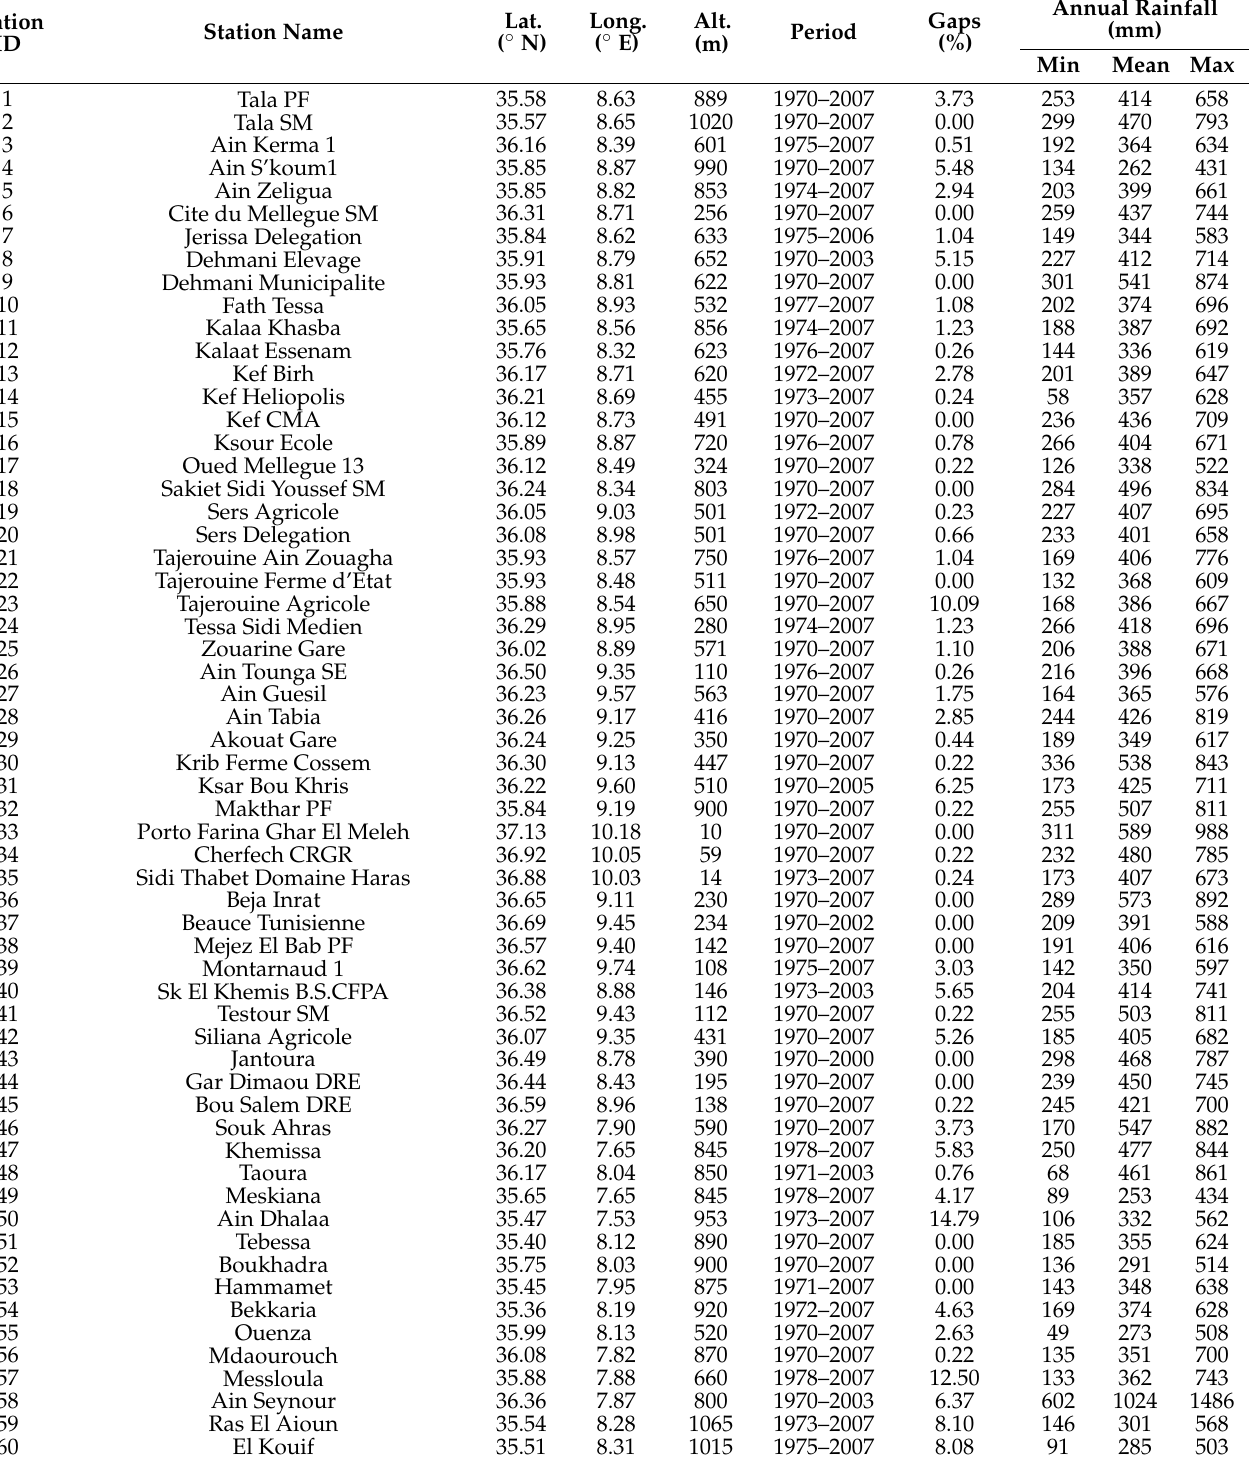
Table 1. Characteristics of the rainfall stations and their corresponding time